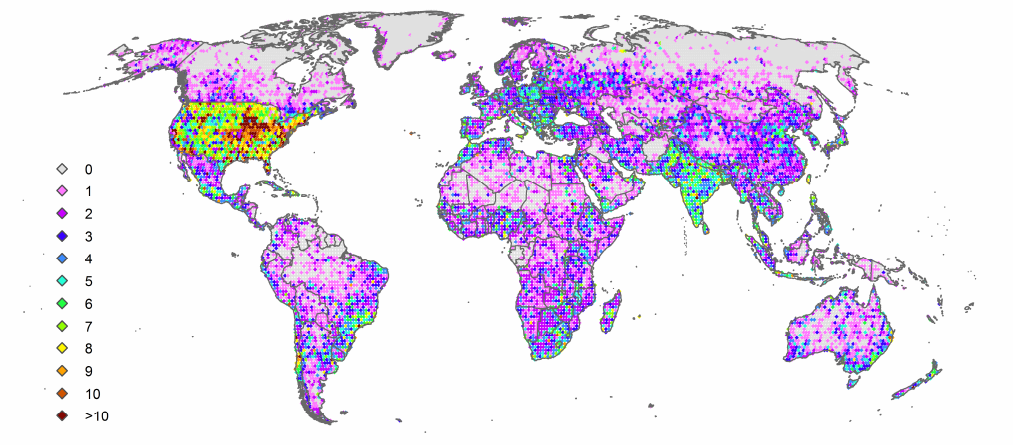
Figure 5. The number of unique years of VHR satellite images (<5 m resolution) available in Google Earth (Software: Esri ® ArcMap™ 10.1).